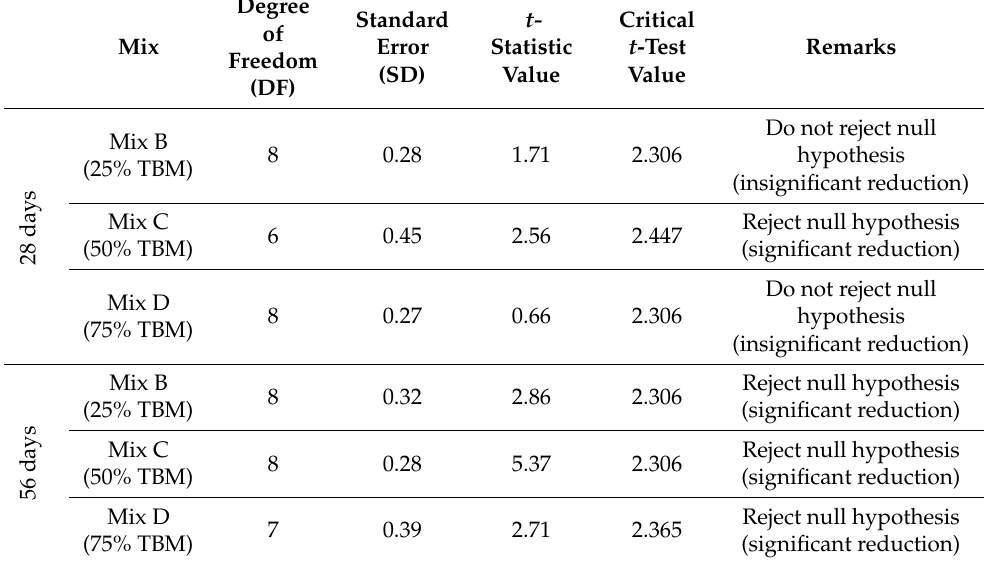
Table 7. Flexural strength t -statistical